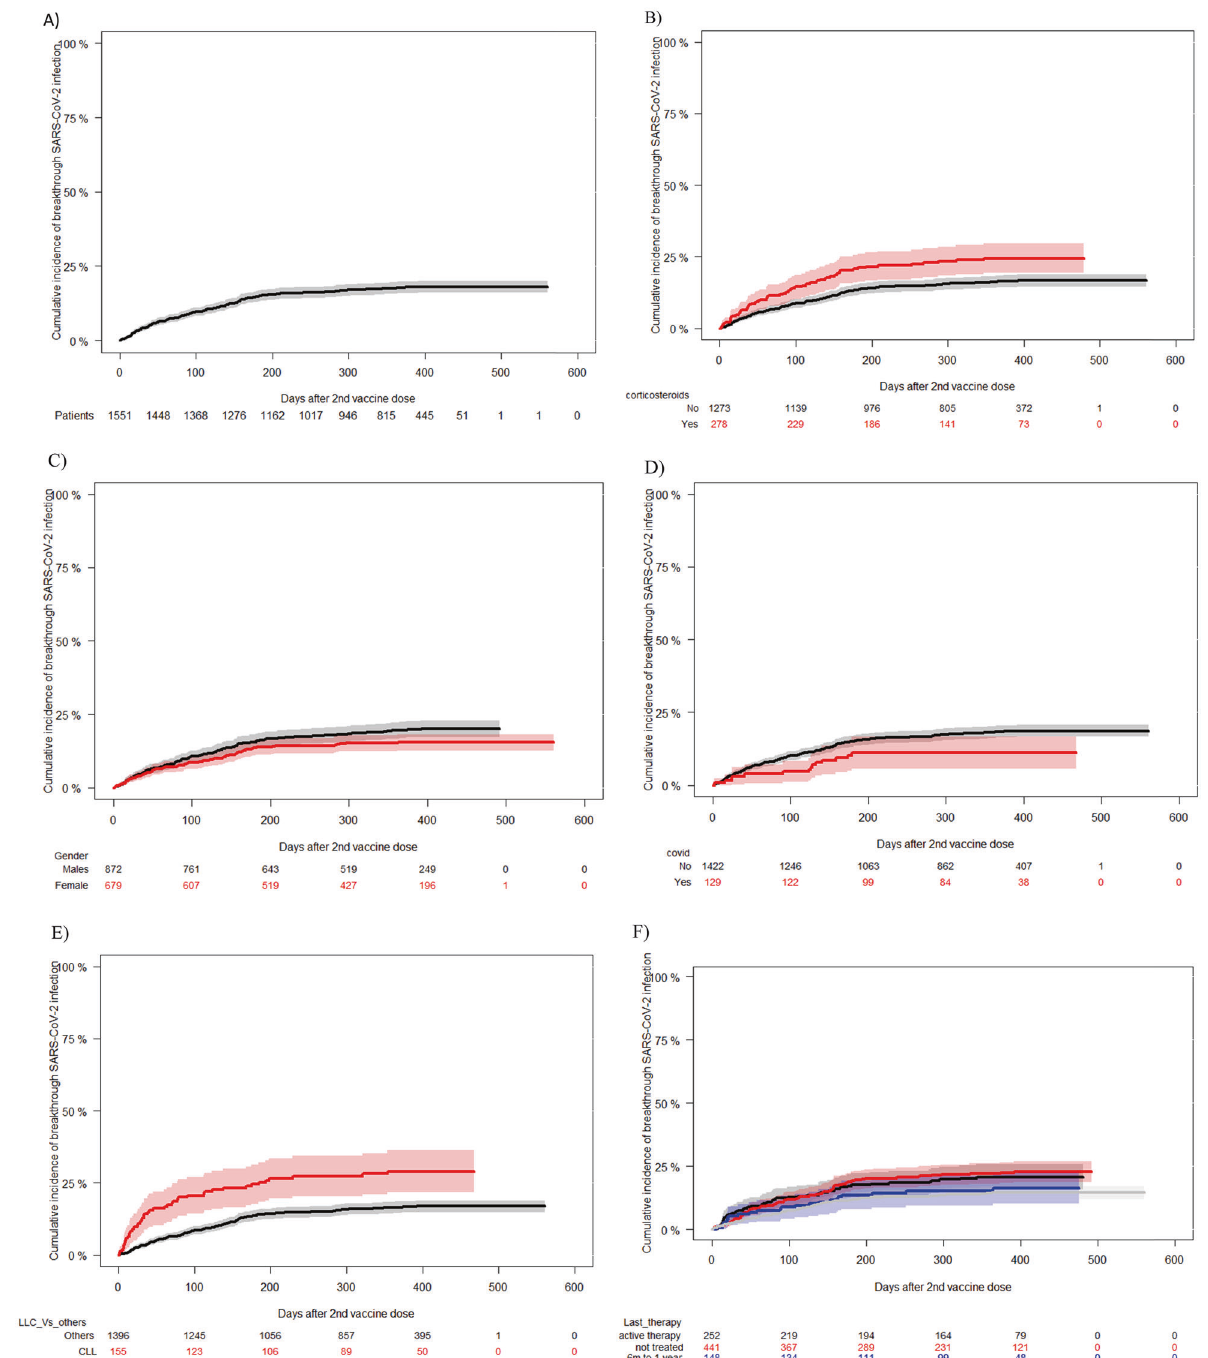
Fig. 2 1-year Incidence of SARS-CoV-2 breakthrough infection. A In the whole cohort [cumulative incidence of 18% (95% con fi dence interval 95%, 16 – 20%)]. B According to the use of corticosteroids at the time of fi rst vaccine dose. [Under corticosteroids cumulative incidence of 24.5% (95% con fi dence interval, 19 – 30%) vs without 16.7%, 95% C.I. 14 – 18 ( p < 0.001)]. C According to the patient ’ s gender. [Male 19.6% (95% con fi dence interval, 17 – 22.4%) vs. female 15.5%, 95% C.I. 13 – 18 ( p = 0.04)]. D According to development of COVID-19 before the fi rst vaccine dose. [Prior COVID-19 11% (95% con fi dence interval, 6 – 17%) vs without 18.4%, 95% C.I. 16 – 20.5, ( p = 0.04)]. E According to chronic lymphocytic leukemia vs others. [CLL 29% (95% con fi dence interval, 22 – 36%) vs. others16.8%, 95% C.I. 15 – 18.9 ( p < 0.001)]. F According to timing of last therapy. [No treated 21% (C.I. 95%, 16 – 26%) vs. active therapy 20.5%, 95% C.I. 18 – 24 vs 6 months to 1 year 16% (C.I. 95%, 10 – 22) vs. >1 year 14% (95% C.I., 12 – 17) ( p = applied not only to immunosuppressed patients and their Supplementary Fig. S2). Preventive transmission measures (hand caregivers but also to those who have a close contact with these washing, social distancing, wearing mask, etc) are still highly patients (friends, other relatives, health staff, etc). We already recommended for patients but are clearly far from being learned that the more thorough preventive transmission satisfactory. It looks suitable that such measures would be